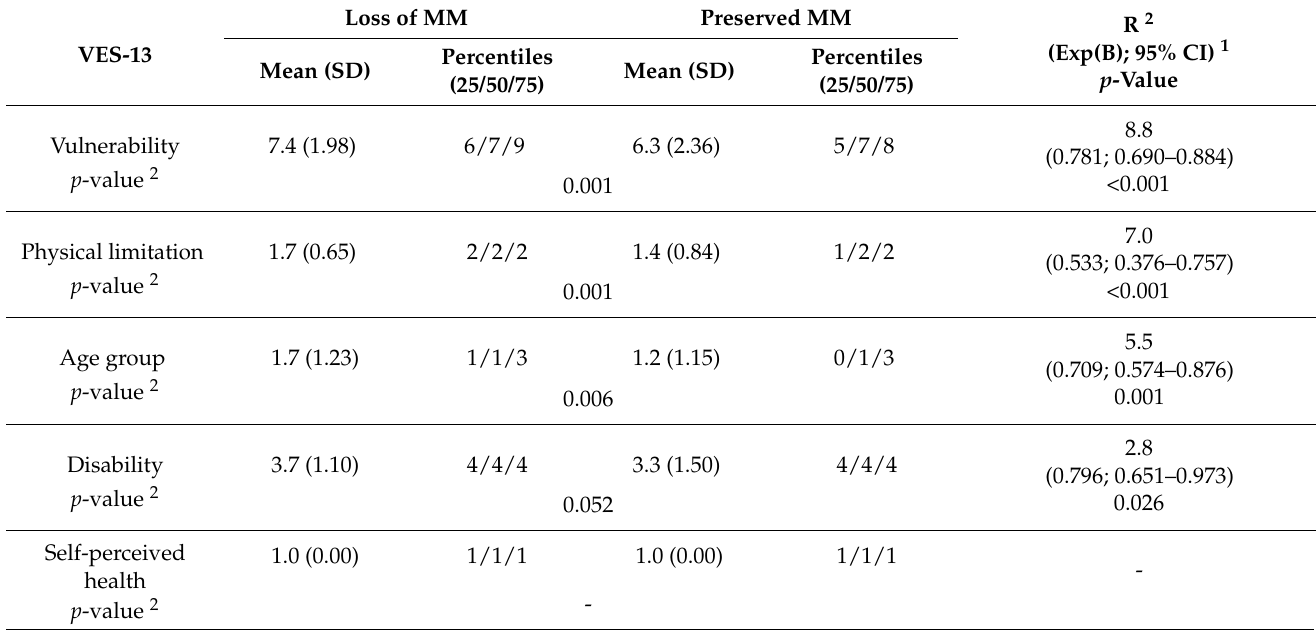
Table 3. Descriptive analysis and binary logistic regression to evaluate the association between muscle mass and VES-13 scores in older adults living in LTCF. Natal, RN, Brazil.